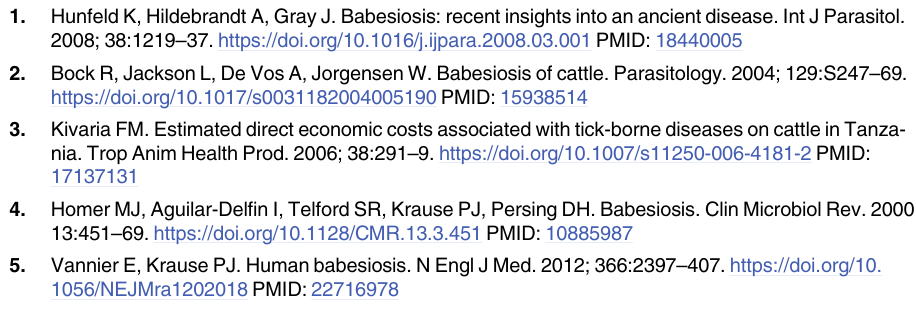
S4 Table. GO terms. Tabs 1–3 contain the list of enriched GO terms for conserved and spe- cies-specific DEGs and human versus bovine DEGs. S5 Table. Functionally related genes. Tabs 1–3 contain the list of orthologous Babesia tran- scription factors (TFs), AP2s, and epigenetic markers. Tabs 4–6 contain the list of VESA genes in B . bovis , B . bigemina , and B . divergens . S6 Table. Gene clusters. Tabs 1 and 2 contain the list of genes in each cluster for epigenetic markers (Fig 8) and TFs and AP2s (Fig J in S1 Text). S1 Text. Additional figures. S1 Text also contains extended analysis on species-specific mark- ers and the human versus bovine marker